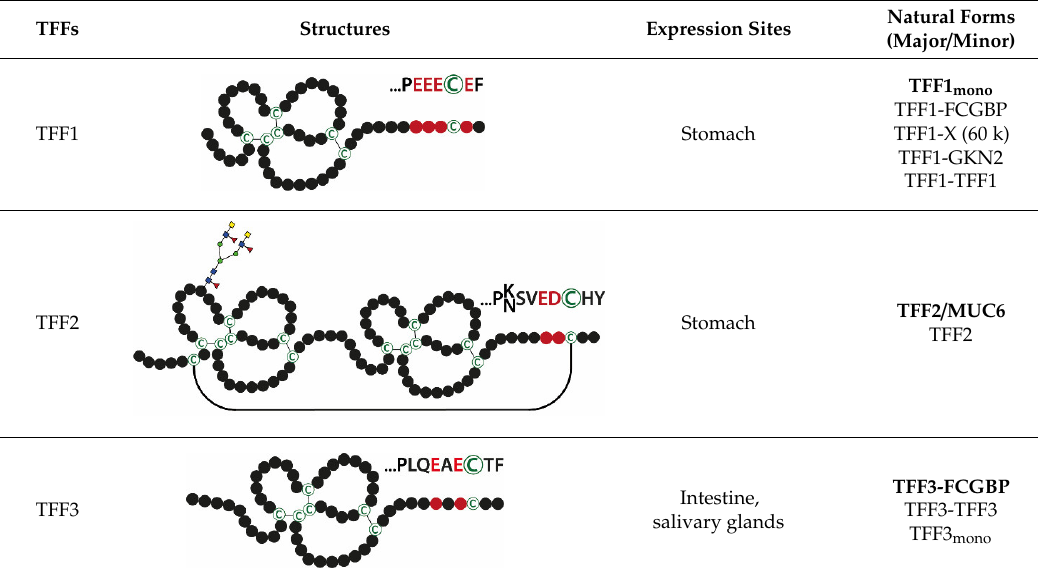
Natural Forms (Major / Minor)